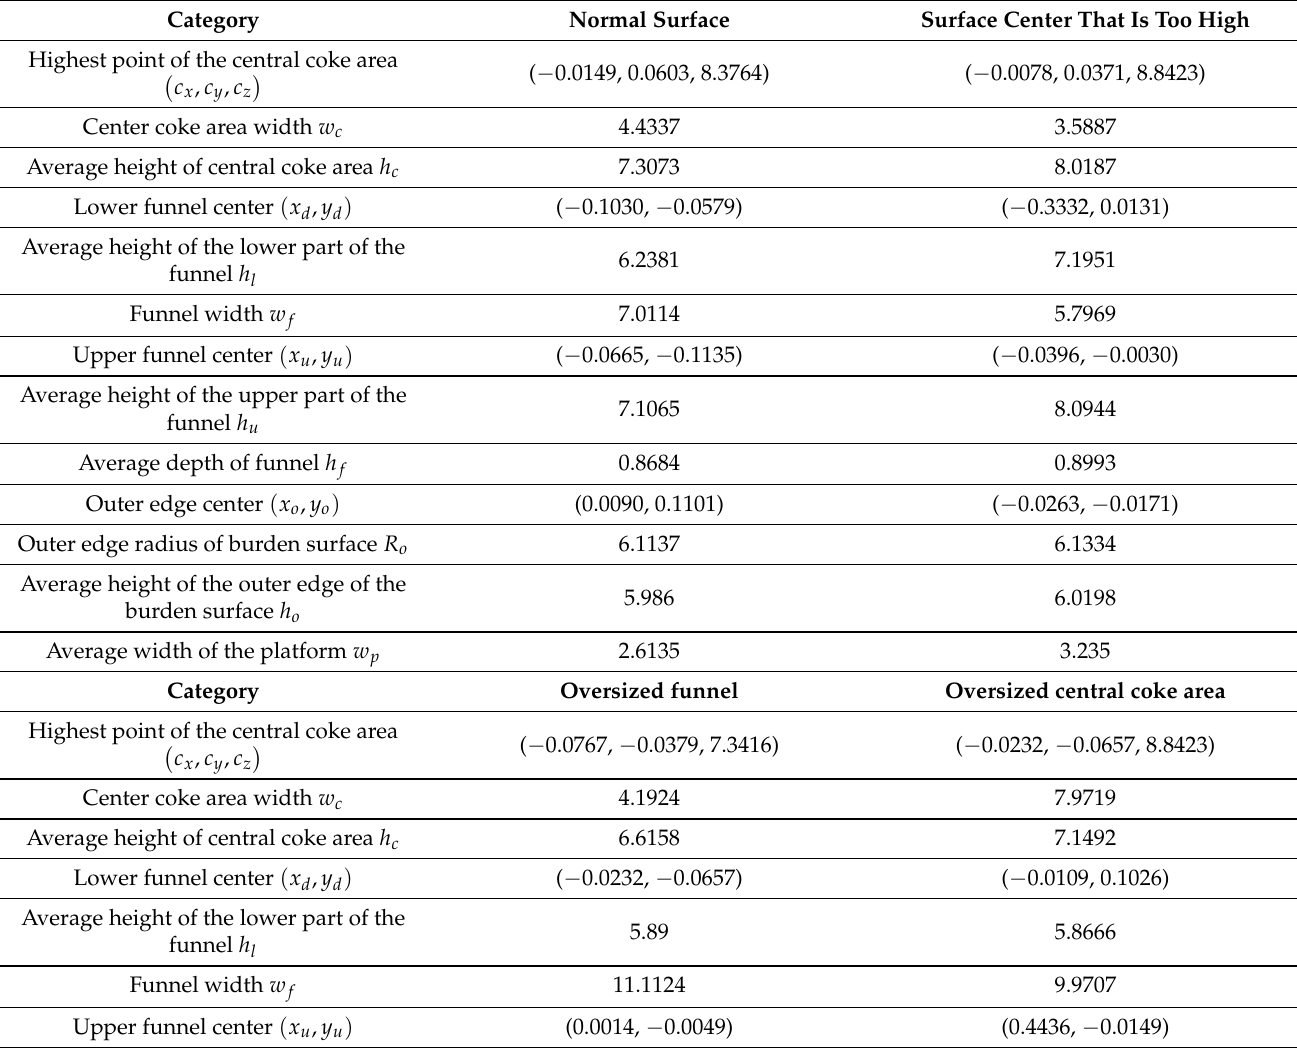
Table 1. Part of the feature